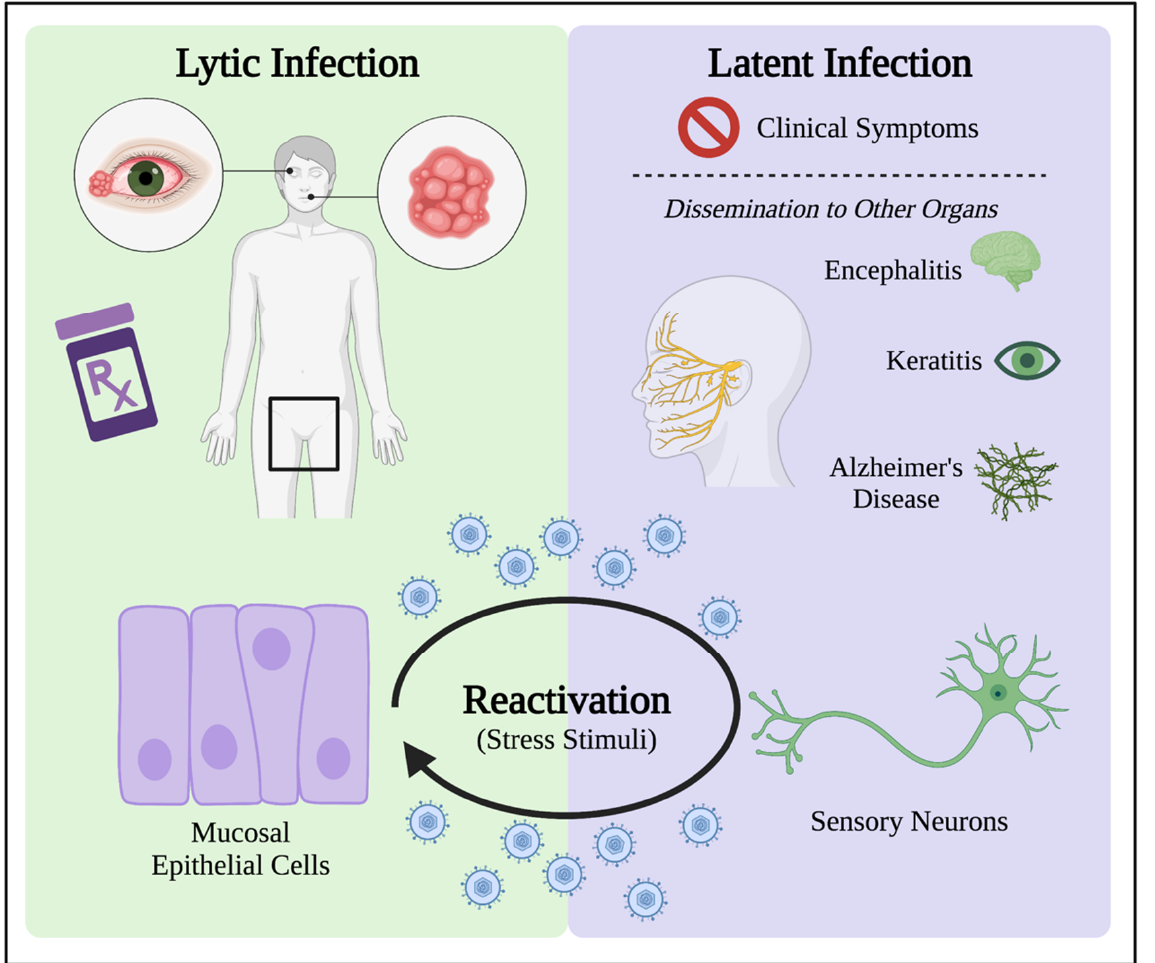
Figure 1. The HSV-1 lifecycle is characterized by the cycle between lytic infection and latent infection over the course of a patient’s life. Infection with HSV-1 is known for causing cold sores that can appear around the mouth, eyes, and genitalia. These clinical manifestations are characteristic of lytic infection, when HSV-1 is actively replicating and producing new viruses in mucosal epithelial cells in these areas. It is at this point in infection where antiviral therapies are administered to alleviate symptoms and shorten the course of virus infection. As clinical symptoms disappear, HSV-1 virions travel to nearby nerves and establish viral latency in peripheral sensory neurons. Latent infection is characterized by negligible viral gene expression, which prevents detection by the host immune system. During the life of the infected individual, HSV-1 lytic infection can become reactivated by stress stimuli. Reactivation can lead to the recurrence of lesions caused by productive, lytic infection, as well as an increased risk of more serious disease.